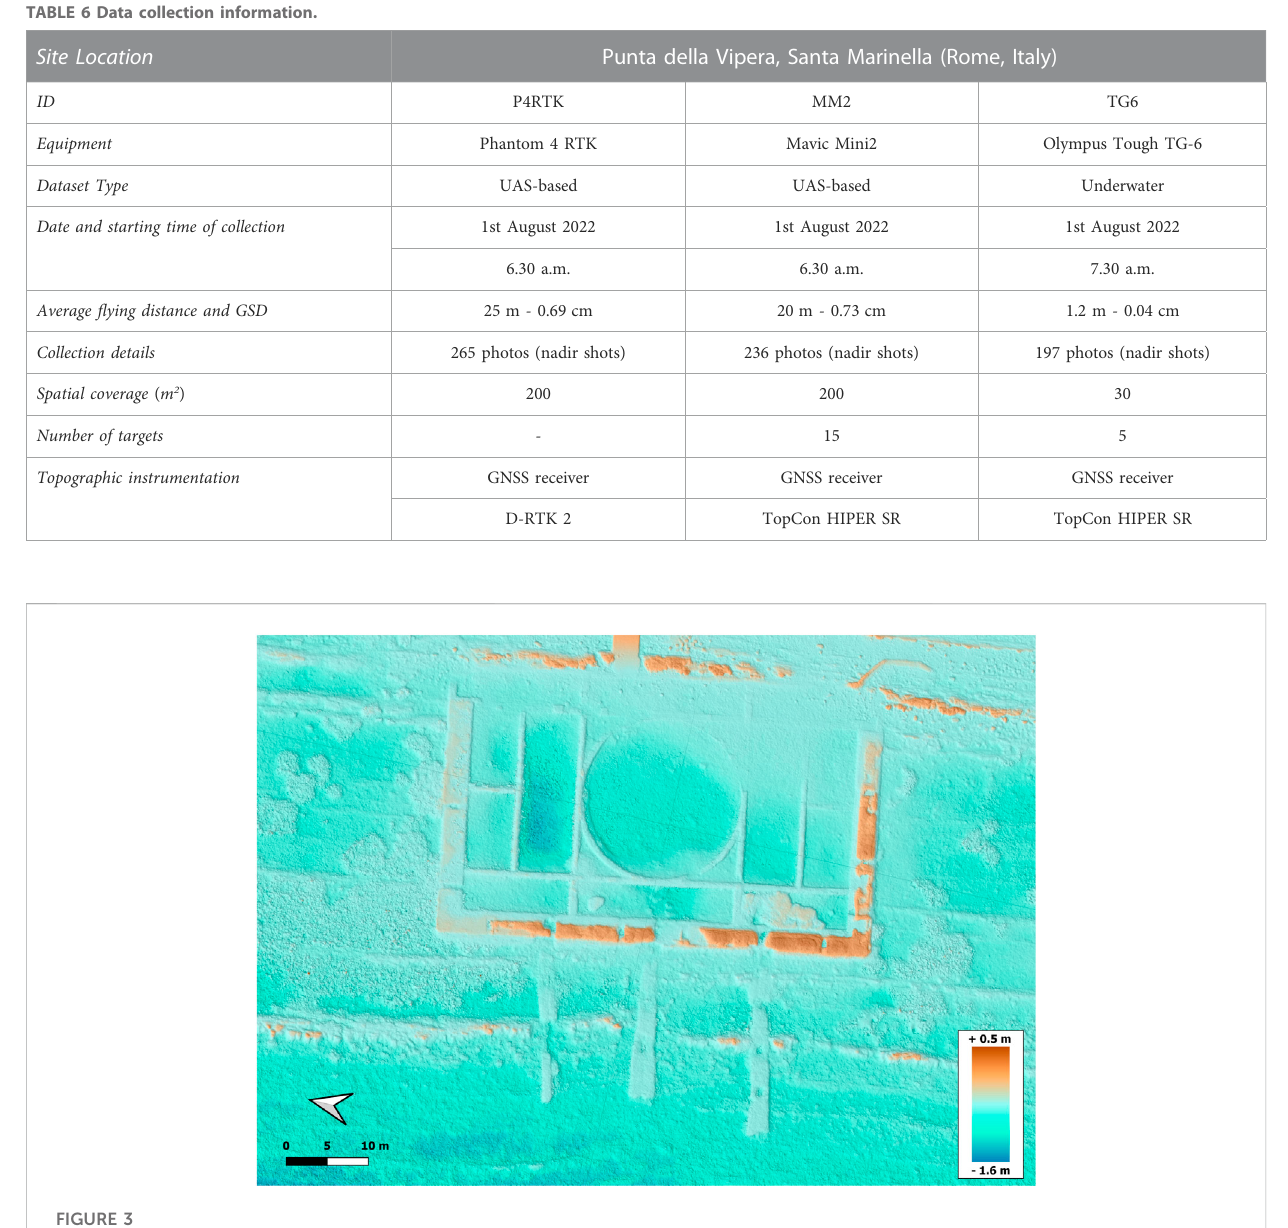
FIGURE 3 Bathymetry of the study site: DEM obtained from the P4RTK